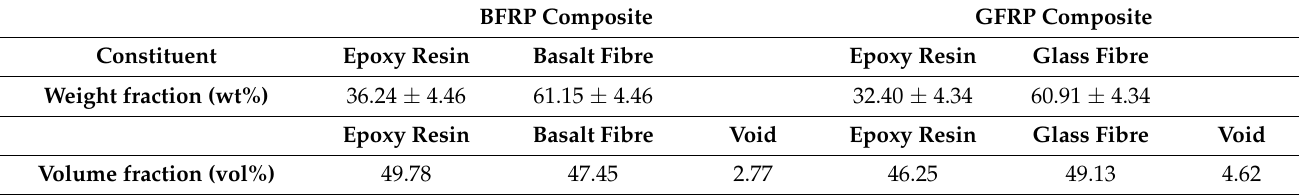
Table 3. Weight, volume and void volume fraction of fibres and matrices of FRP